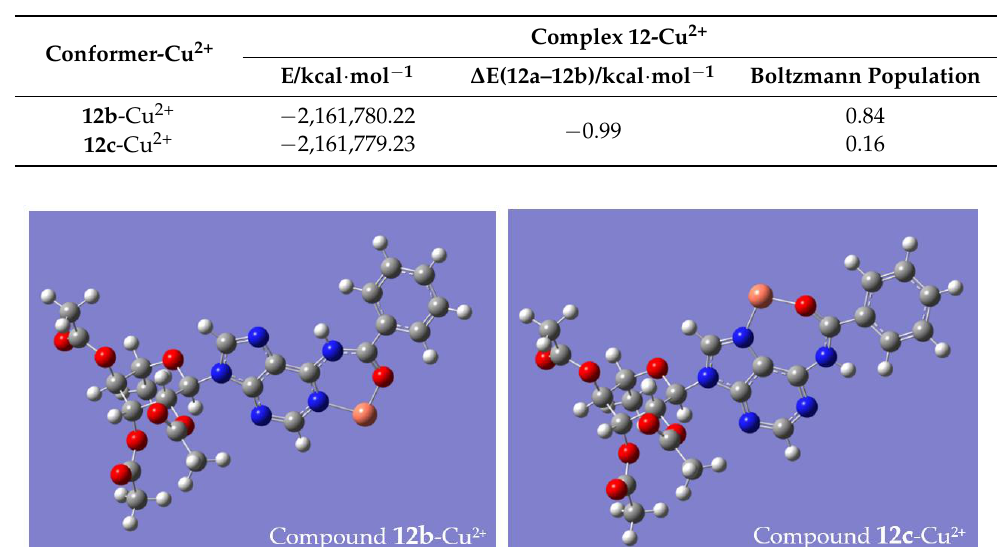
Figure 6. Final optimized geometry of the complexes 12 -Cu 2+ determined in Gaussian16 with CAM/B3LYP/def2TZVP and IEFPCM for water.